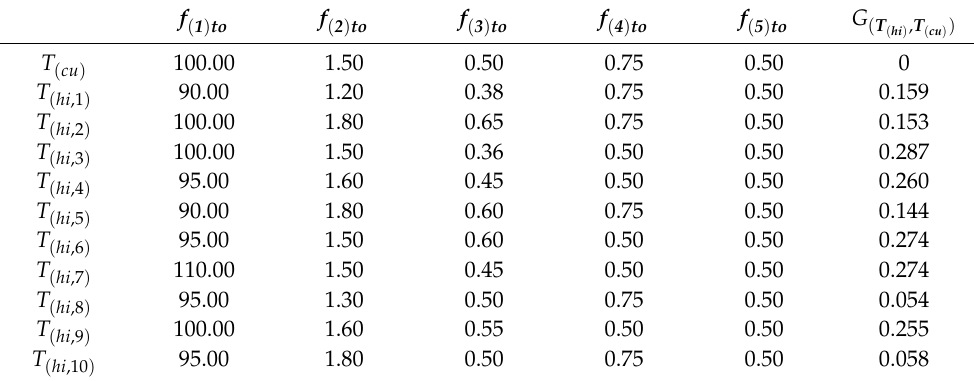
Table 3. The feature attribute factors f ( k ) to of the historical tourists T ( hi ) and the current tourist T ( cu ) , as well as the searching objective function G ( T ( hi ) , T ( cu ) )